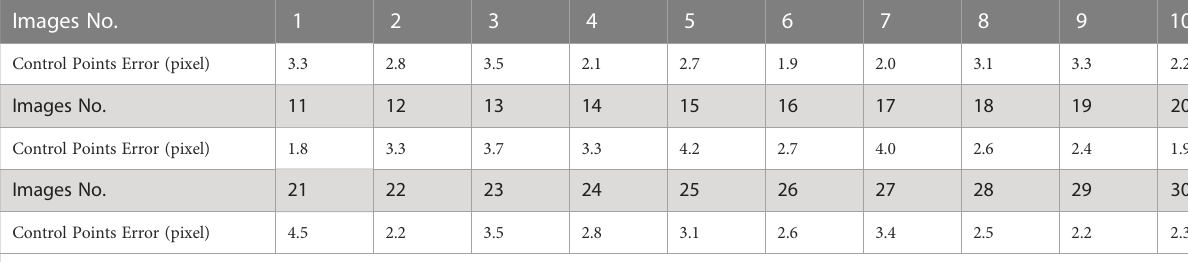
TABLE 3 Control Points Error between color image and transformed thermal image. Images No.